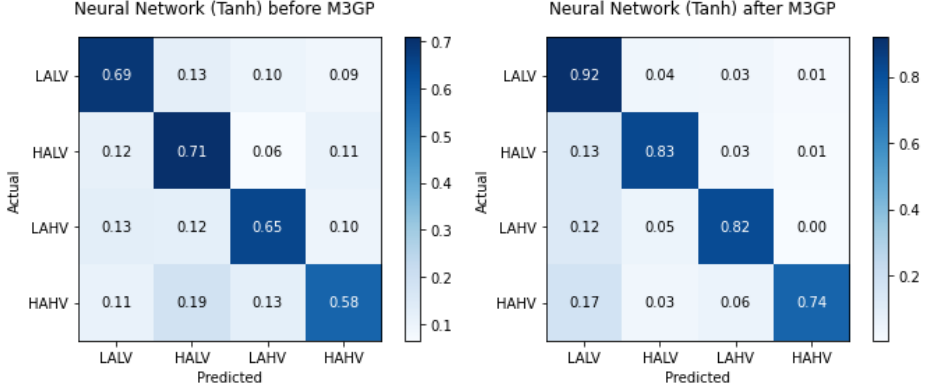
Figure 11. Classification results with Tanh: on the left-hand side is the classification without treatment; on the right-hand side is the classification with the M3GP transformation.